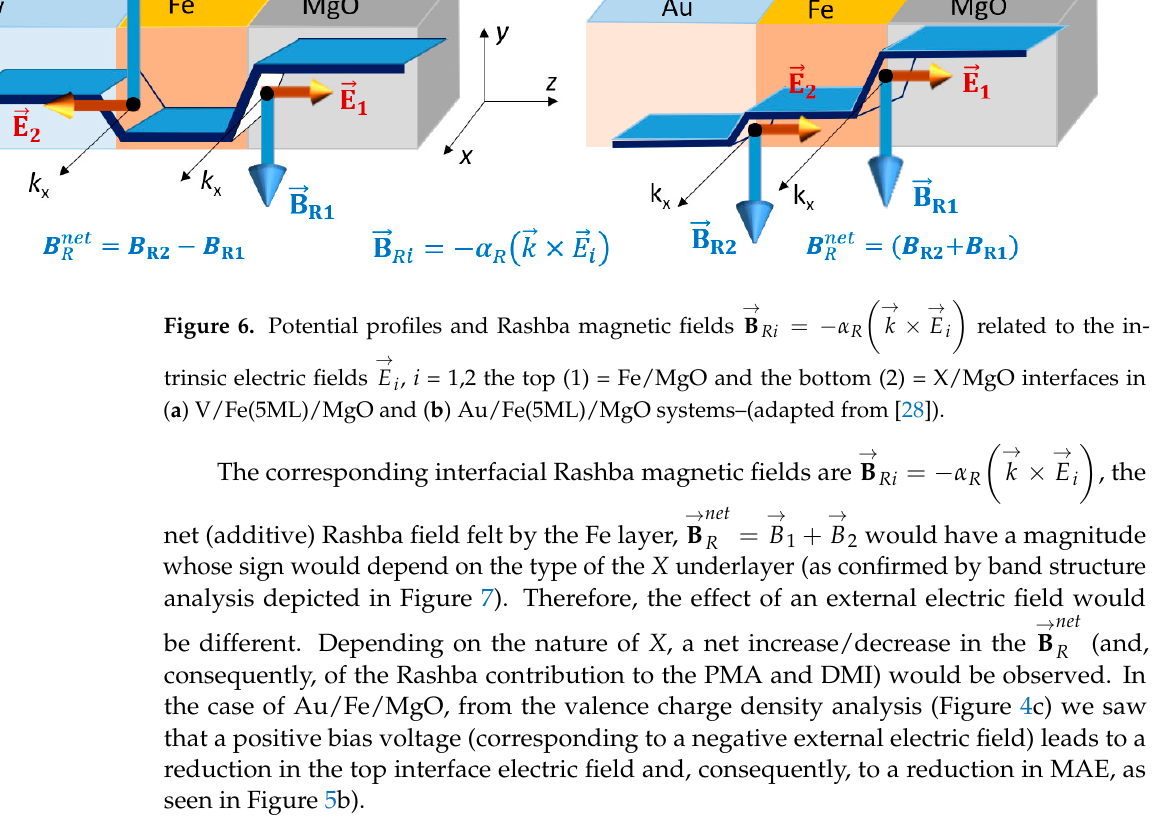
related to the in- (cid:18) → (cid:19) → → k × E i B Ri = − α R , the → → net → = B 1 + B 2 would have a magnitude B R